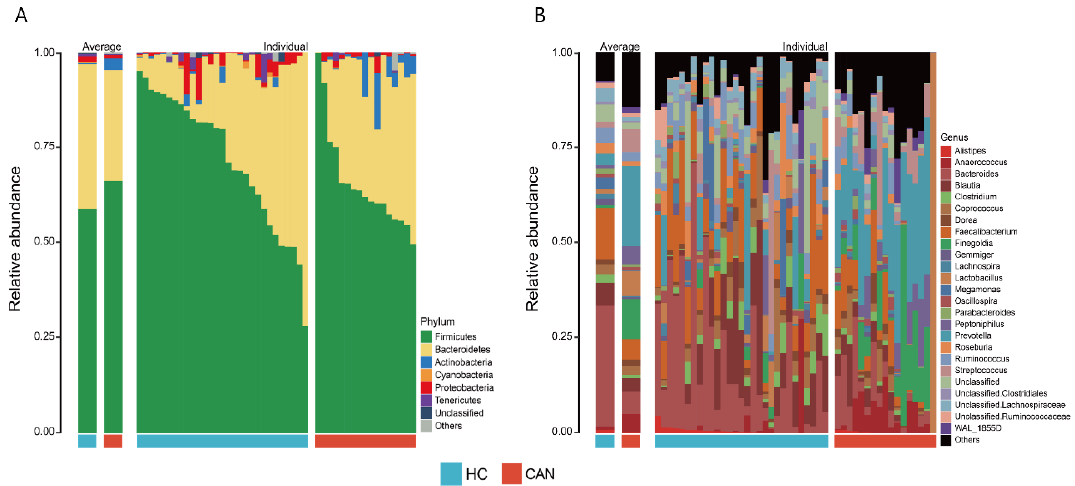
Figure 1. Relative abundance of fecal microbiota composition at the phylum ( A ) and genus ( B ) levels by health statuses (HC vs. CAN). The left panel of each figure represents the average relative abundance. The right panel displays the individual relative abundance of each sample. The top seven phyla and top 25 genera are presented.